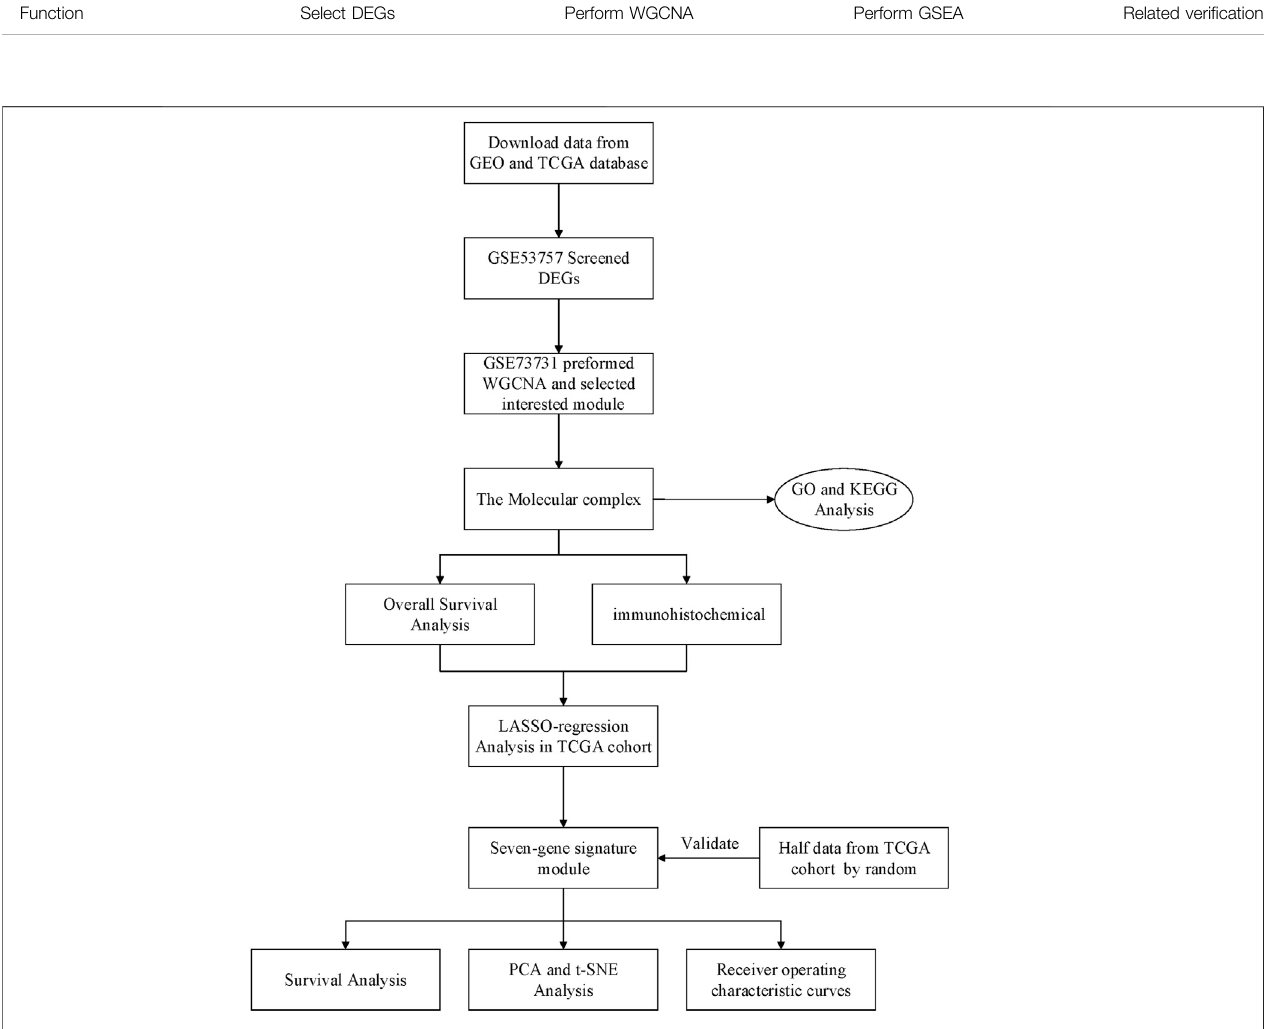
FIGURE 1 | Flow chart of data collection and